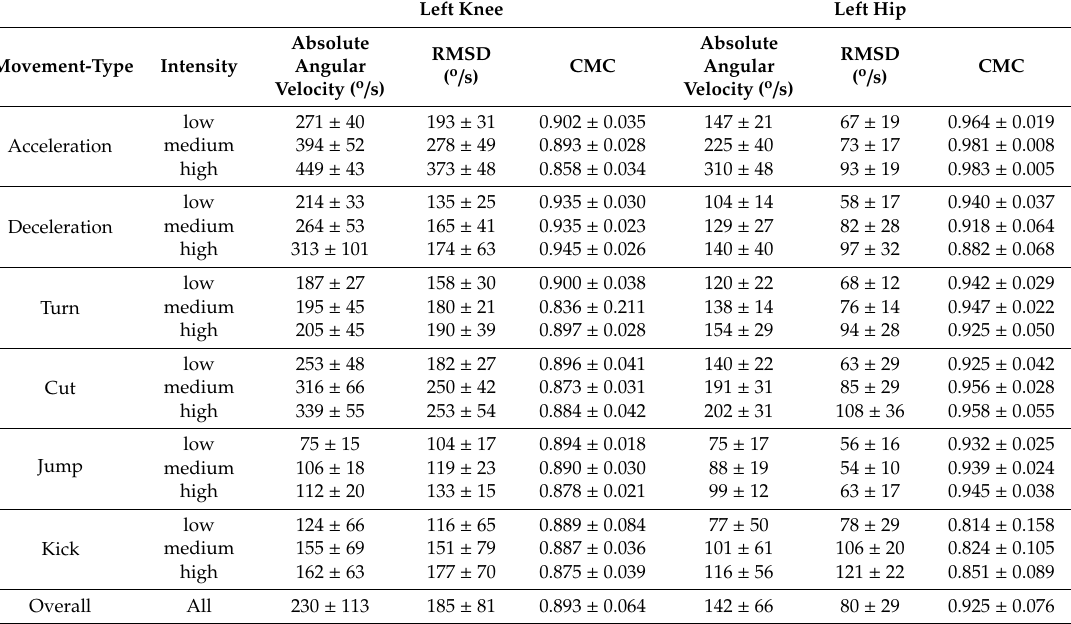
Table 2. Results flexion / extension joint angular velocities. Mean absolute joint flexion / extension angular velocities of the left leg obtained by the inertial motion analysis system, and the root mean square di ff erences (RMSD) and coe ffi cients of multiple correlation (CMC) between knee and hip flexion / extension angular velocities obtained by the optoelectronic and inertial based motion analysis